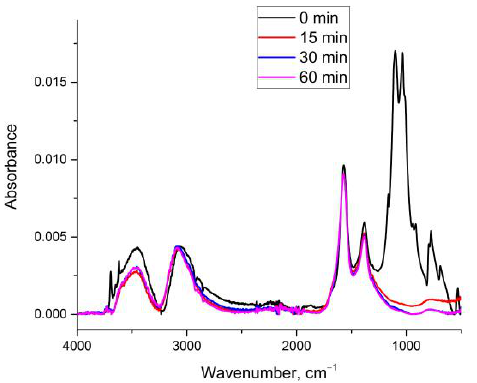
Figure 3. ATR spectra of an aqueous solution of Powhumus humate with a concentration of 75 g/L before and after 15, 30, and 60 min of centrifugation.